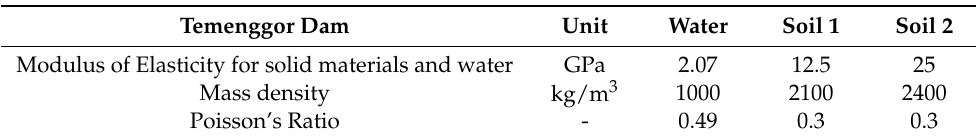
Table 5. The soil and water physical